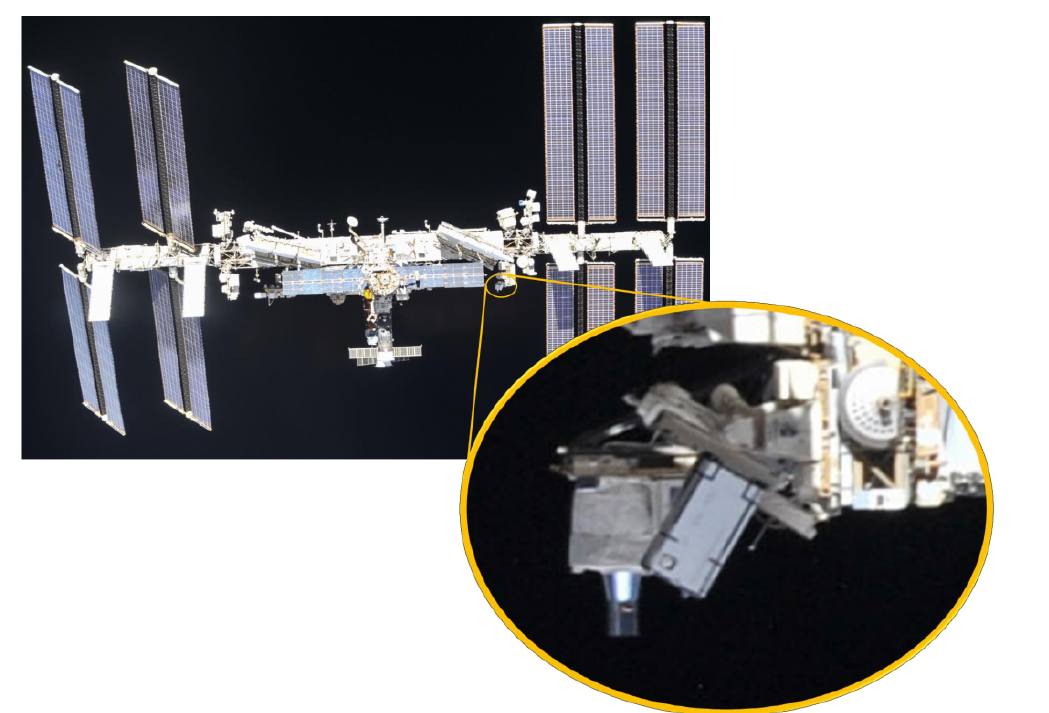
Figure 13. DESIS operating on MUSES onboard of the International Space Station (ISS), photo taken 4 October 2018 from Sojus MS-08. Credit: NASA.